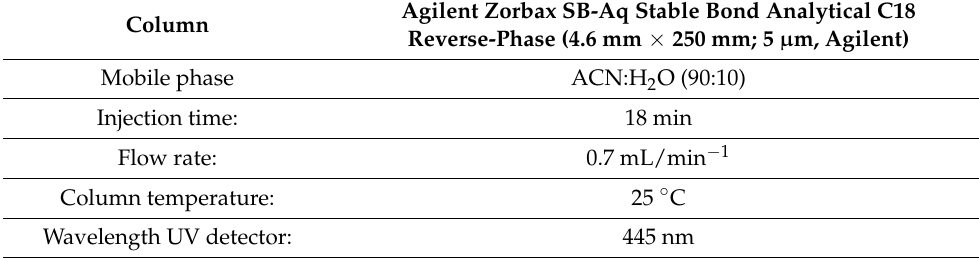
Table 1. Optimized conditions for chromatographic analysis by